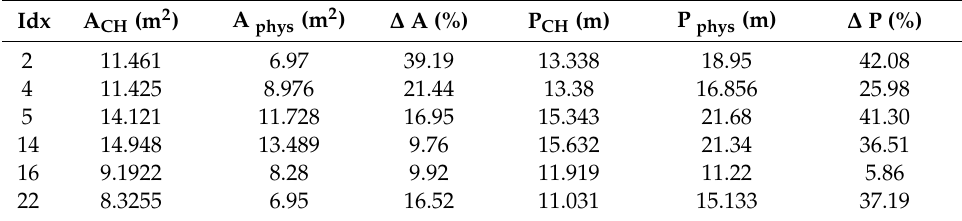
Table 8. Physical area and perimeter, di ff erence in percent from convex hull (X-axis).